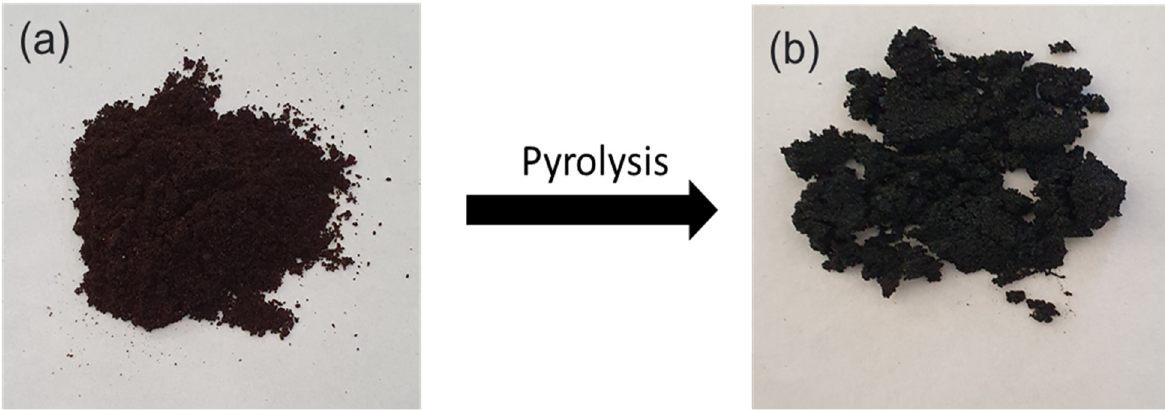
Figure 1. ( a ) spent coffee; ( b ) biochar.